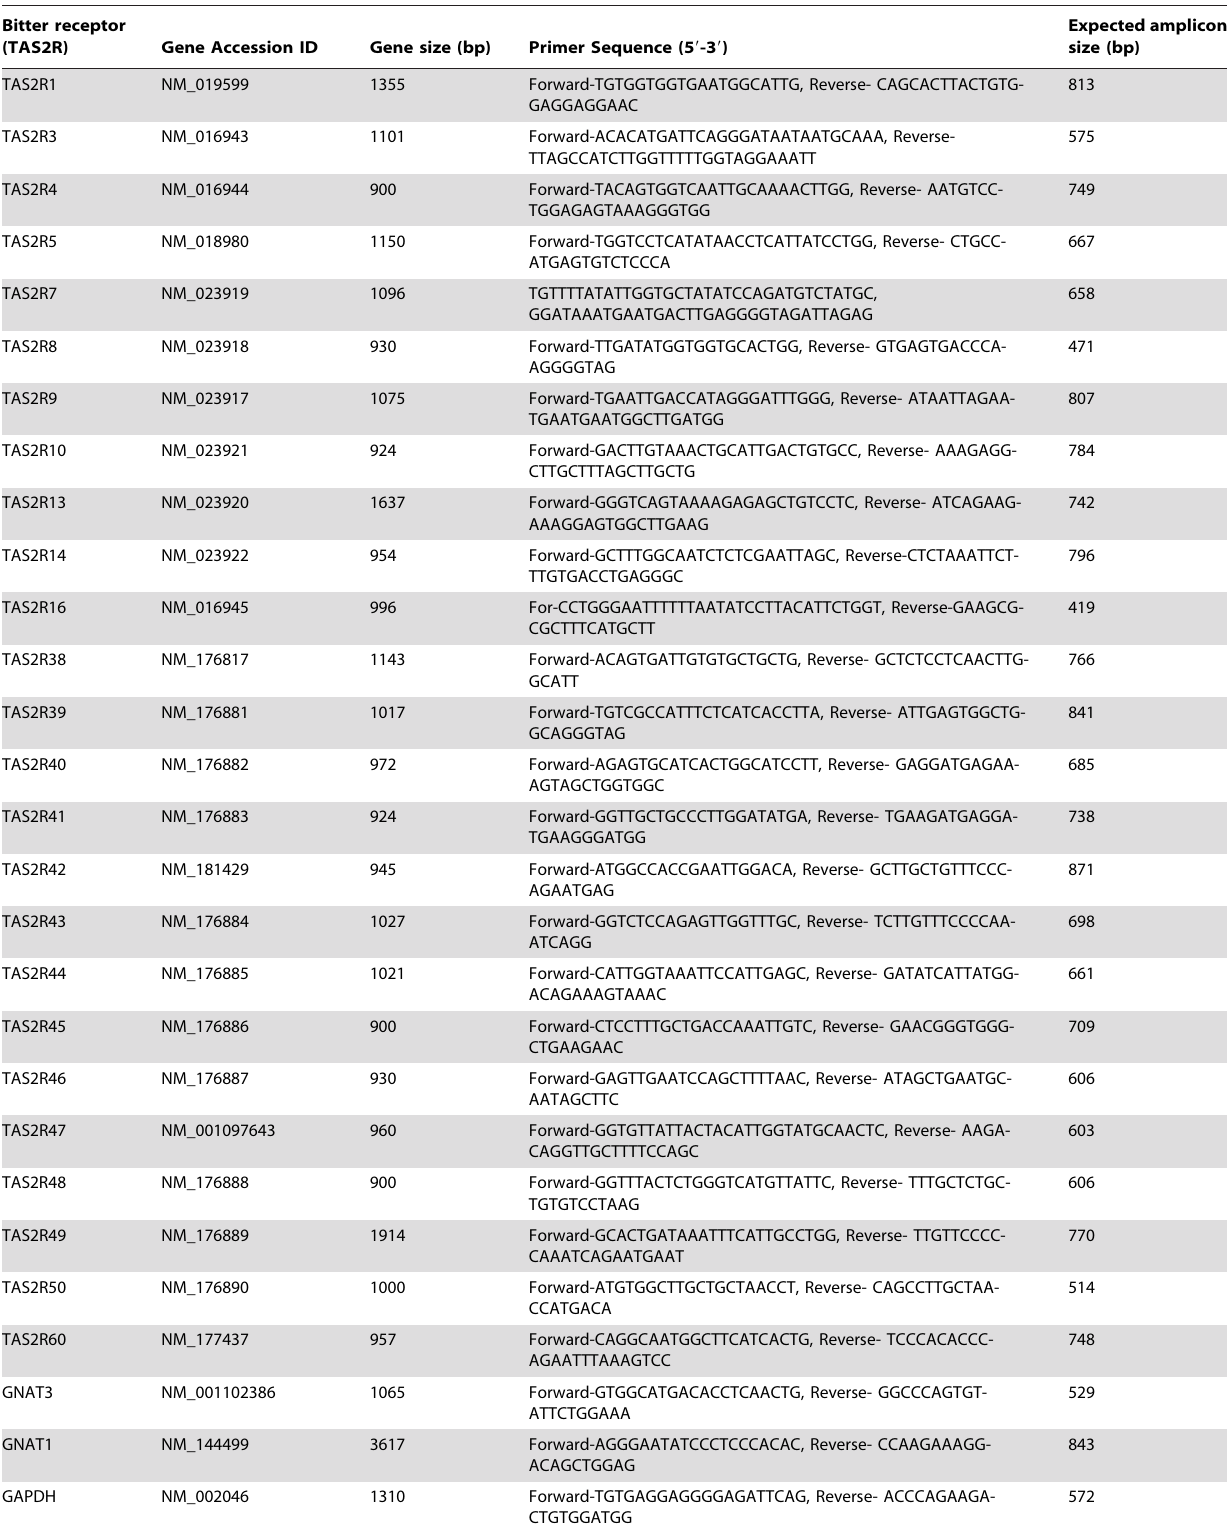
Table 1. DNA primer sequences for human bitter taste receptors